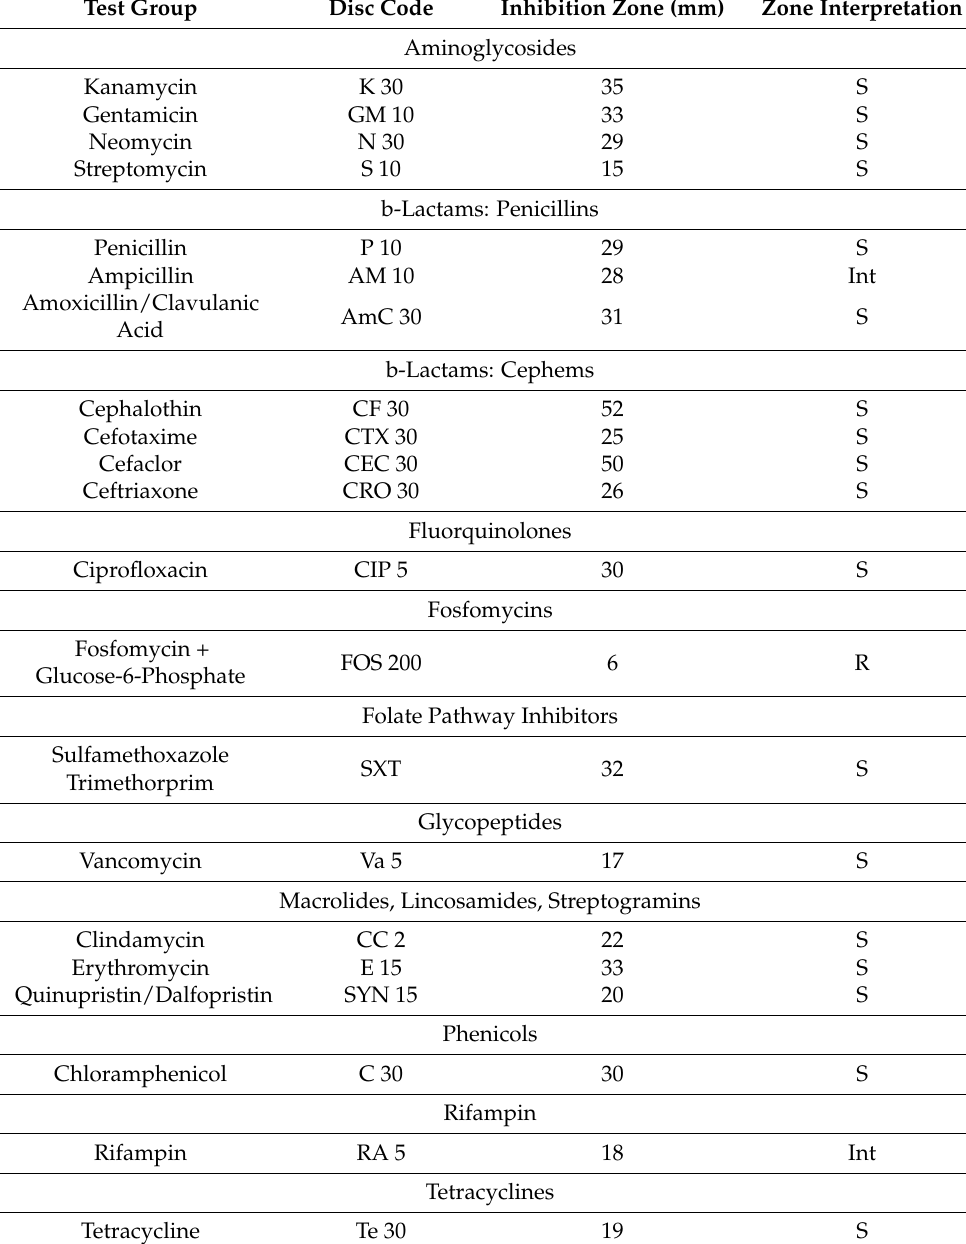
Table 1. Antibiotic Sensitivity Testing summary results for B. subtilis